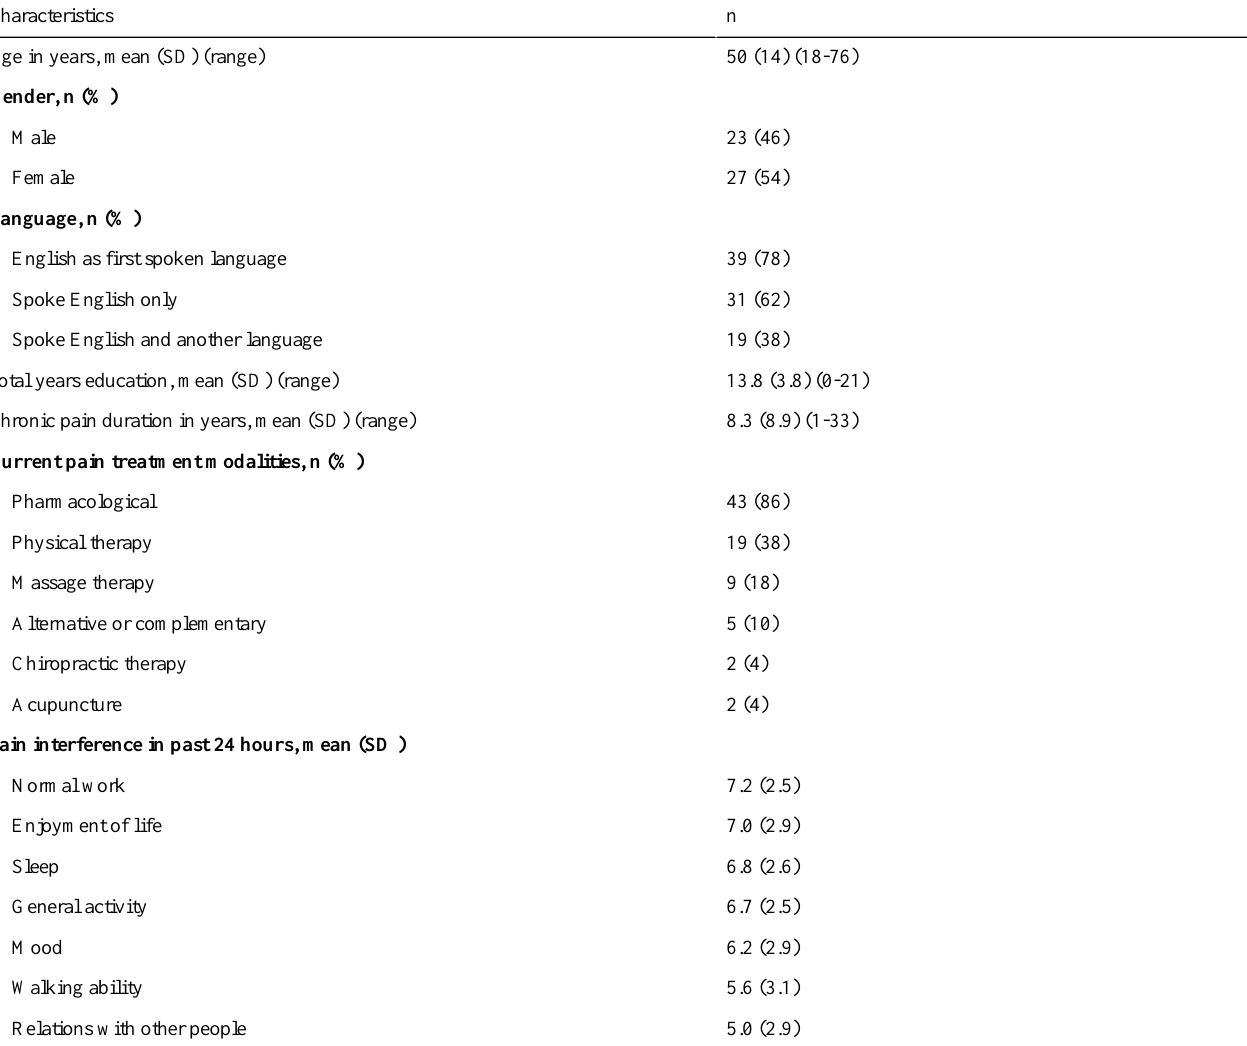
Table 1. Characteristics of study participants (N=50).